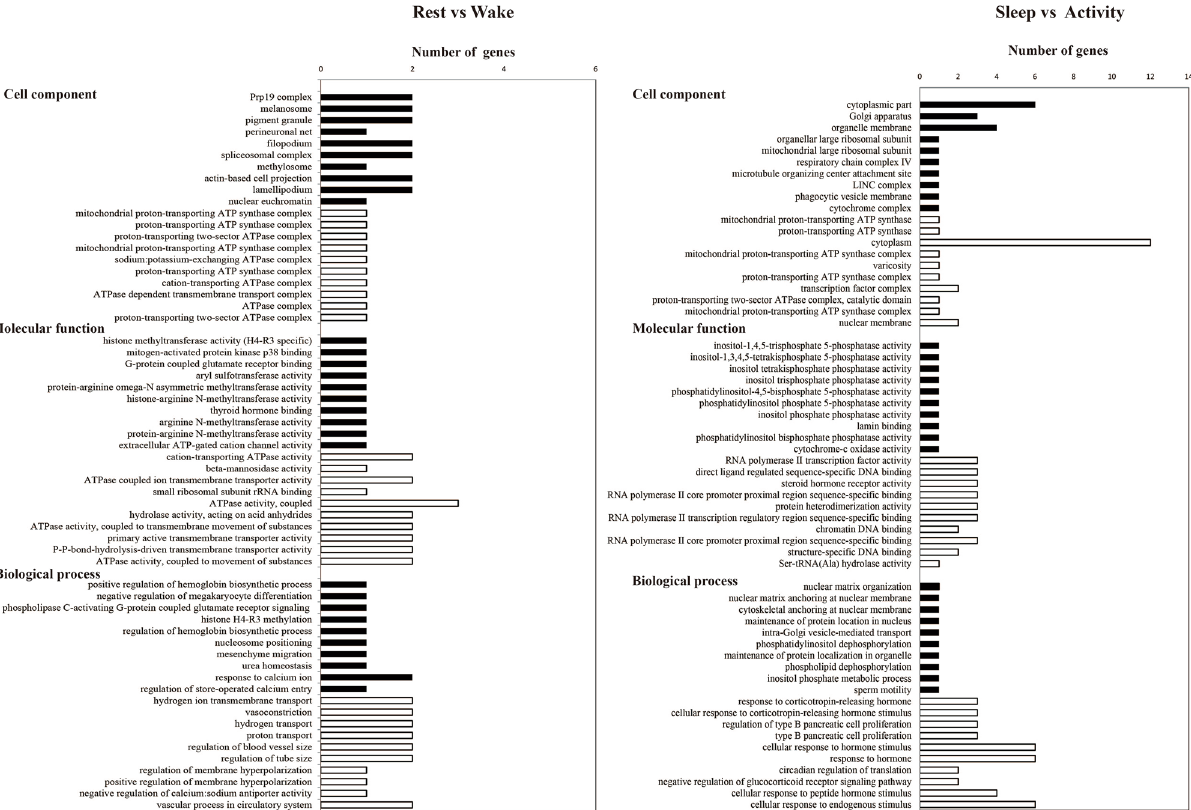
Figure 2. The top 10 GO categories with the most significant p values (cell component, molecular function, and biological process) were significantly enriched for upregulated and downregulated genes in rest vs wake and sleep vs activity comparisons. The black and white bars represent the terms significantly enriched for upregulated and downregulated genes, respectively.